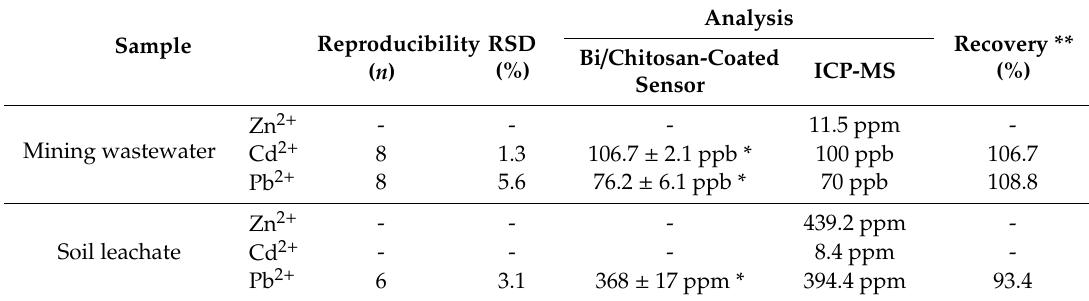
Table2. Heavymetaldetectioninrealenvironmentalsamples(23 ◦